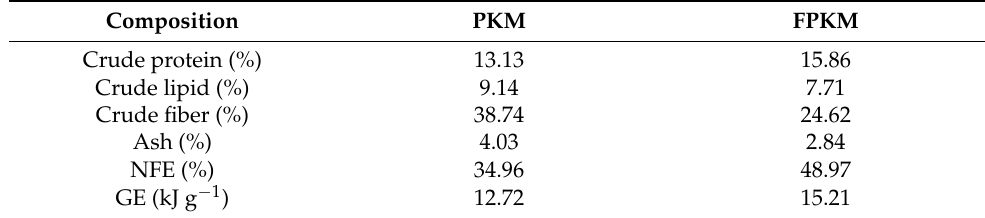
Table 2. Proximate chemical compositions (% of dry matter) of PKM and FPKM. The data given are means from duplicate